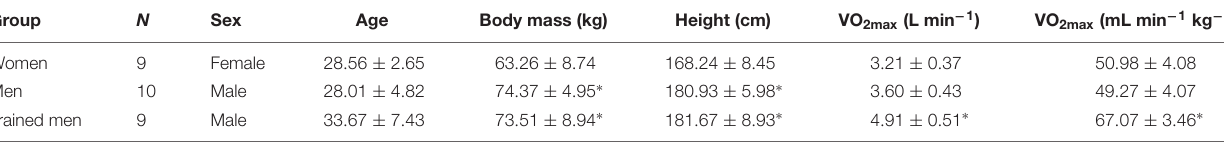
TABLE 1 | Subject’s